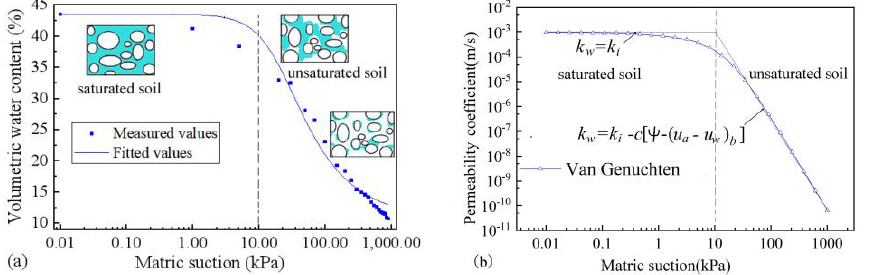
Figure 2. Relation of saturated-unsaturated soil volumetric water content, permeability coefficient and matric suction. ( a ) Soil-water characteristic curve; ( b ) permeability coefficient and matric suction curve.